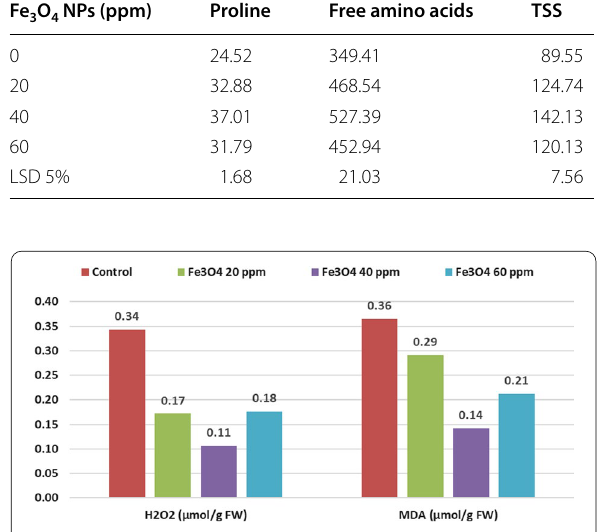
Fig. 3 Effect of foliar application with Fe 3 O 4 NPs on hydrogen perxide and lipid peroxidation of Moringa oleifera L. (LSD 5%: H 2 O 2 MDA 0.008) =